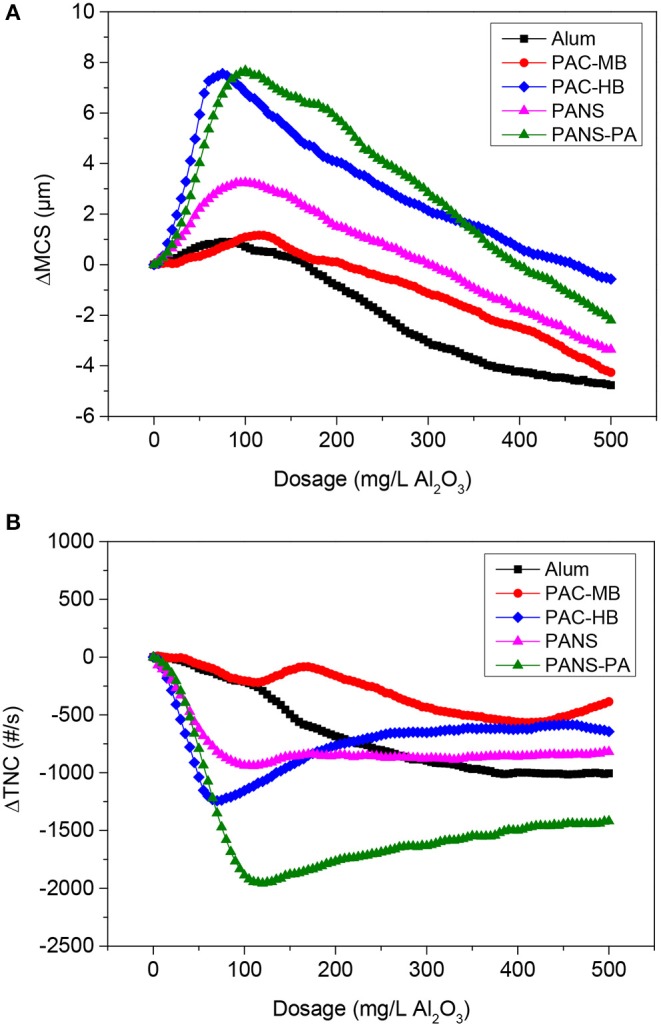
(A) ΔMCS and (B) ΔTNC vs. dosage of coagulants without flocculant addition (MCSo = 41.7 μm, TNCo = 2,860 #/s).